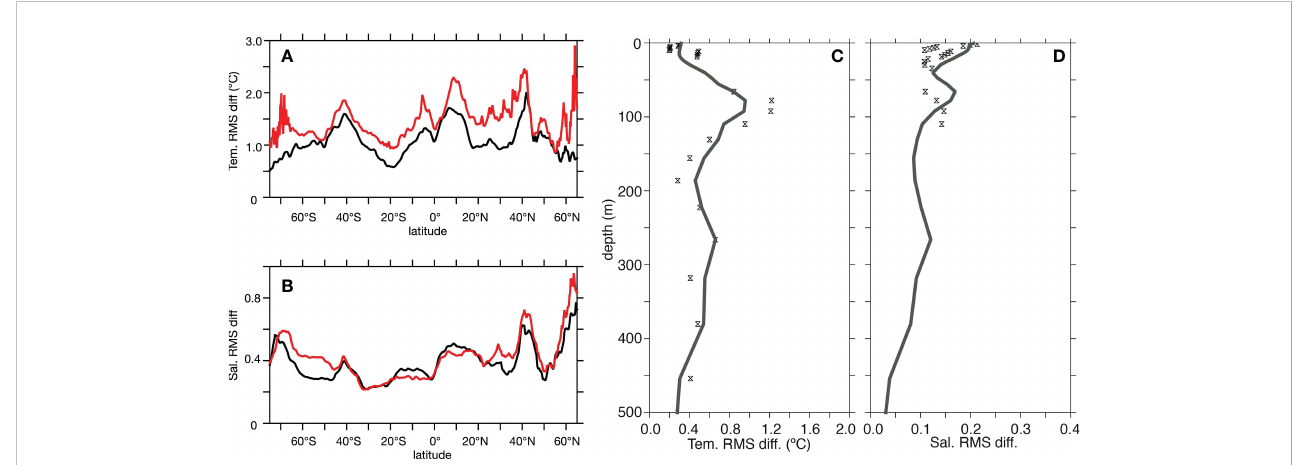
FIGURE 3 (A, B) 100-m temperature and 10-m salinity RMS difference, zonally averaged, between the free and assimilated simulations for the OSSE system (FREE and NOMINAL; black) and the reanalysis system (FREEGLORYS12 and GLORYS12; red). (C, D) Temperature and salinity RMS residuals (difference of OSSEs fi elds from the Nature Run fi elds) at 23°W, 0° (Atlantic) from the OSSE system (distance between NOMINAL and synthetic observations) and the GLORYS12